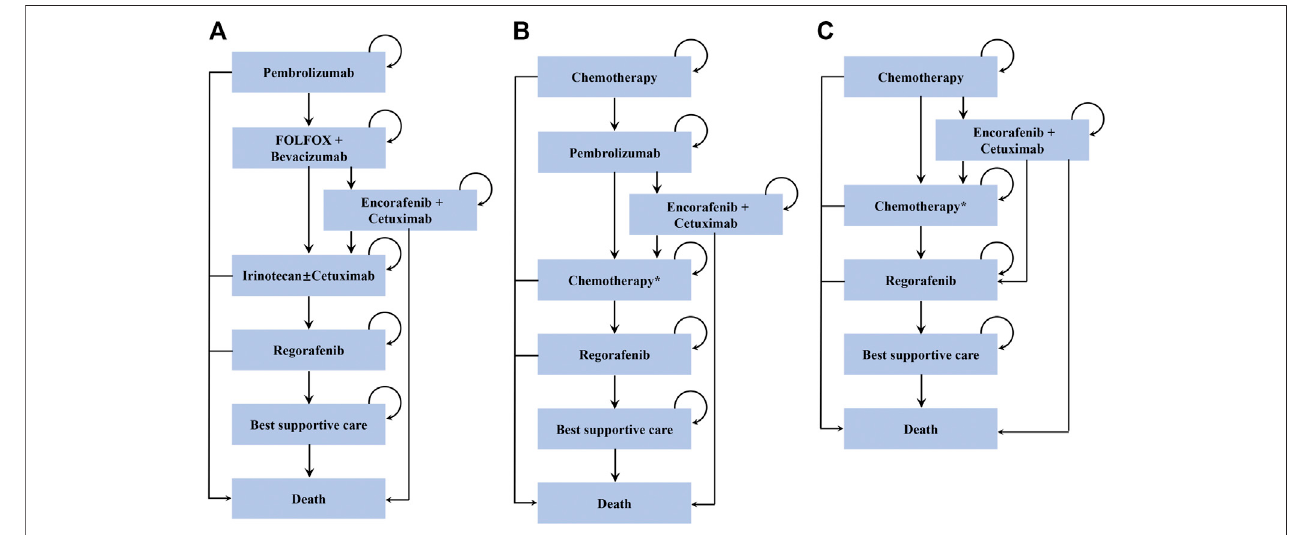
FIGURE 1 | Treatment sequences used in the model. (A) Treatment sequence for patients who receive pembrolizumab in the fi rst-line setting. (B) Treatment sequence for patients who receive pembrolizumab in the second-line setting. (C) Treatment sequence for patients who receive chemotherapy.